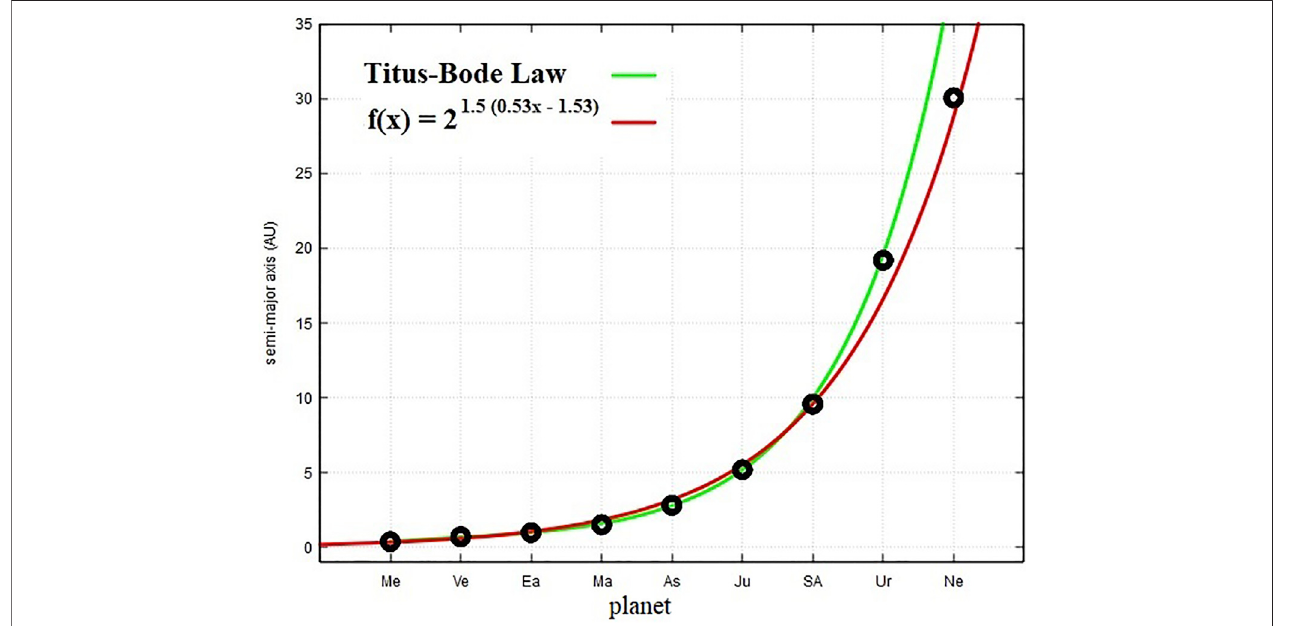
FIGURE 1 | The semi-major axes of the planets versus the Titus-Bode law and a simple exponential fi t.